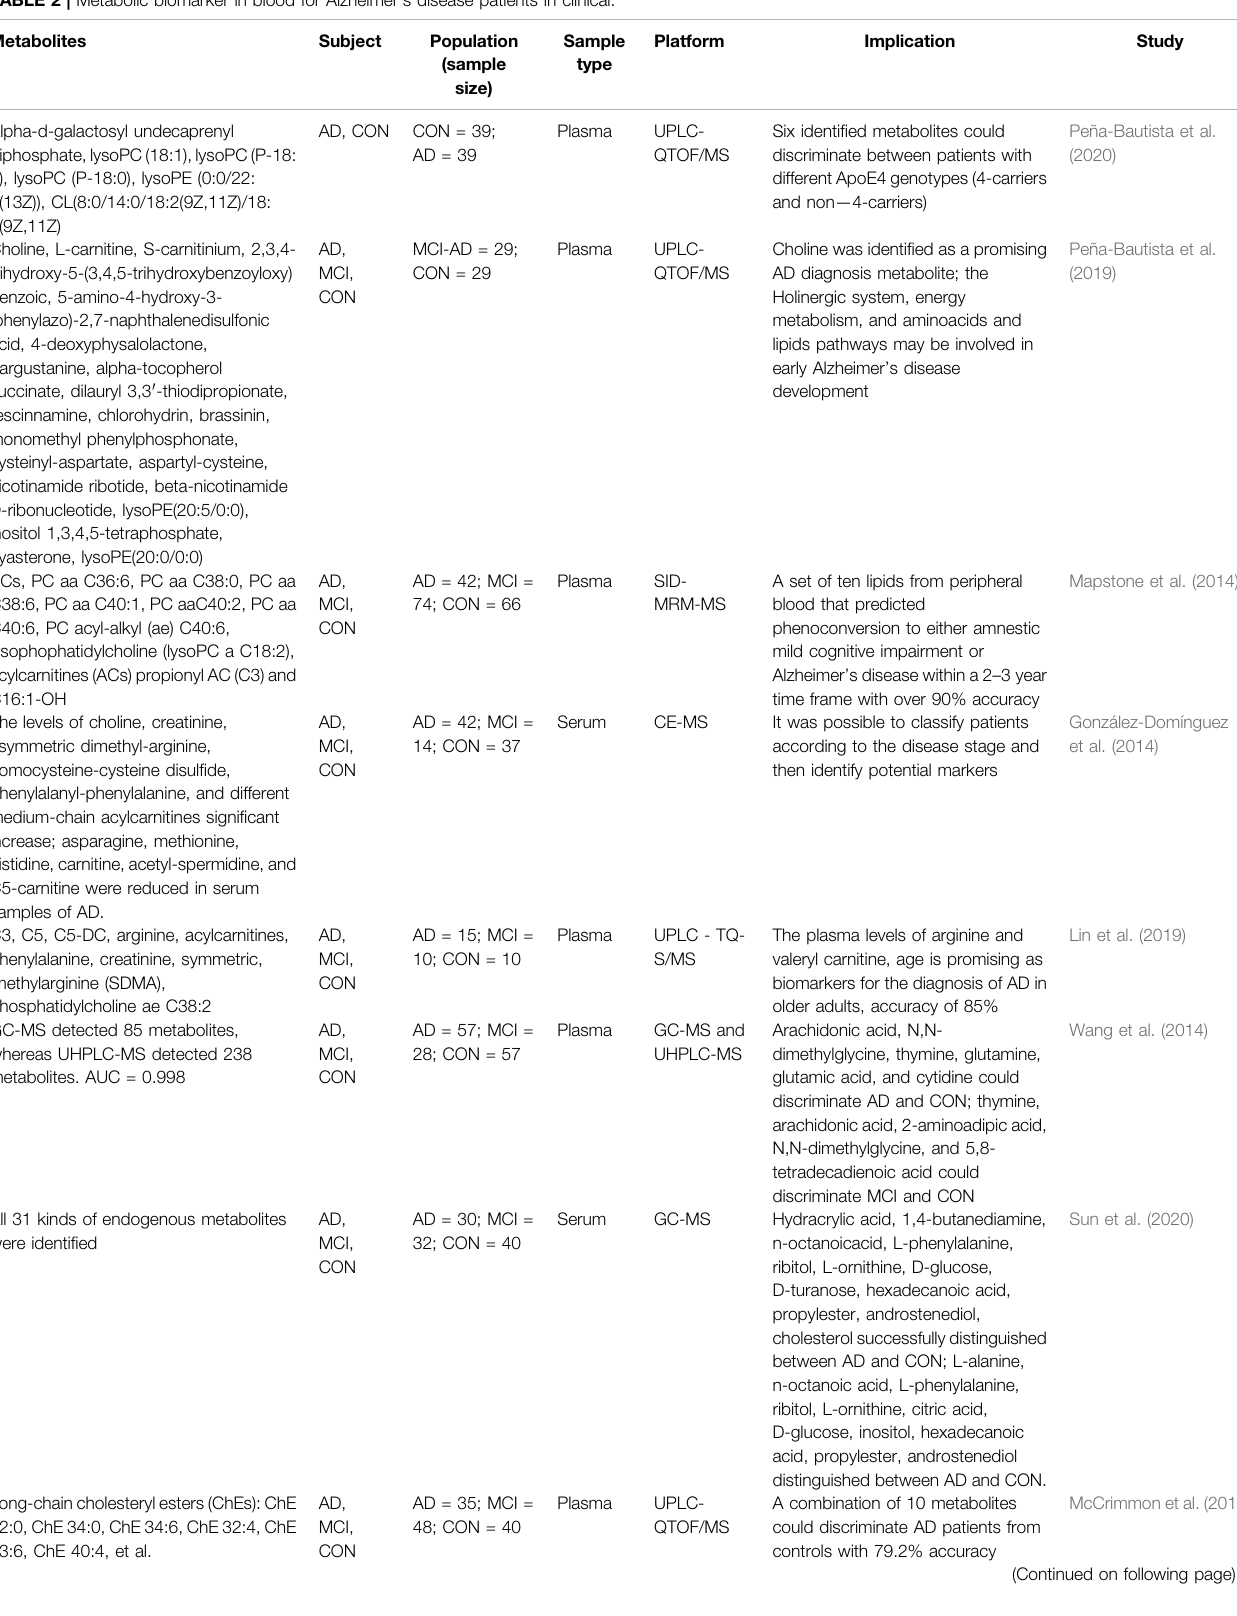
TABLE 2 | Metabolic biomarker in blood for Alzheimer ’ s disease patients in